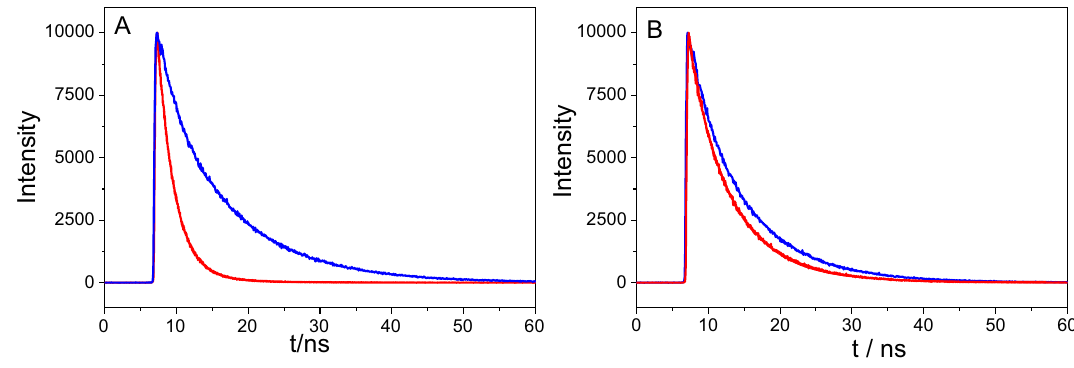
Figure 8. Decay of a fluorescence recorded for TPPNH 2 (red) and GO-CONHTPP (blue) in: ( A ) DMF and ( B )